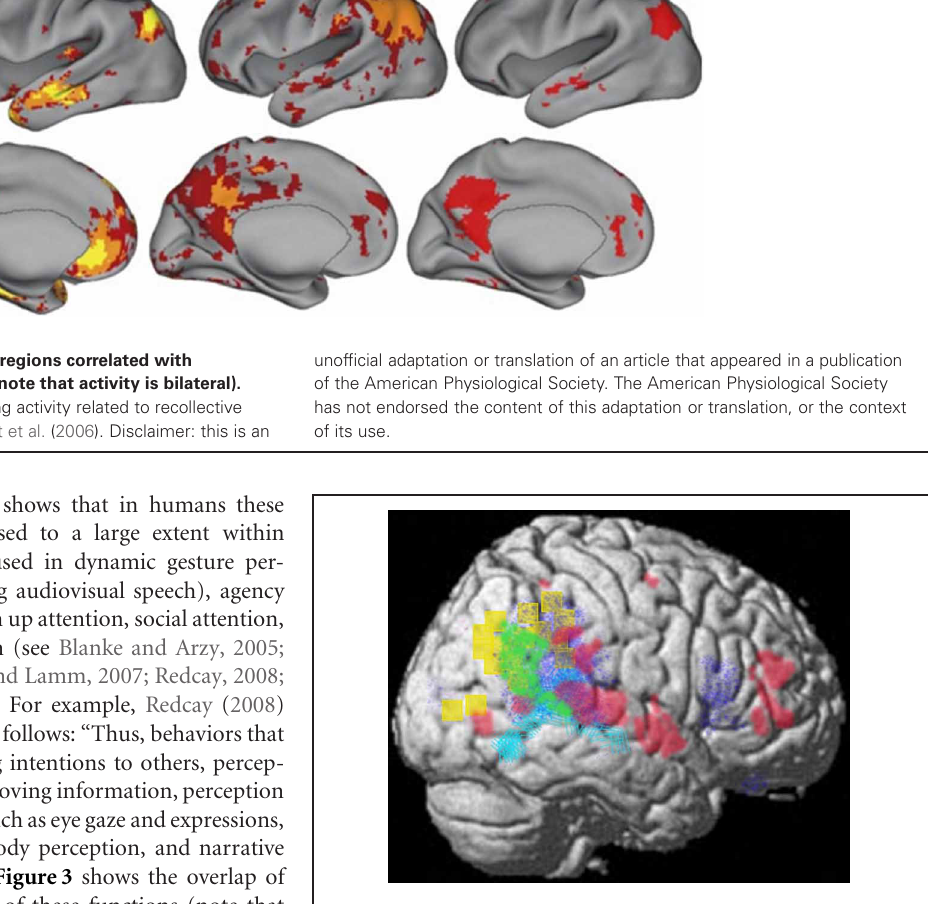
FIGURE 3 | Summary figure of the overlap of functional regions in the TPJ/PSTS involved in eyegaze (red); audiovisual speech (light blue); self representation (yellow); theory of mind (green); emotional perception of faces and prosody (dark blue). Rerepresentation of data respectively from (Adolphs et al., 2002; Wright et al., 2003; Blanke and Arzy, 2005; Nummenmaa et al., 2010; Young et al.,